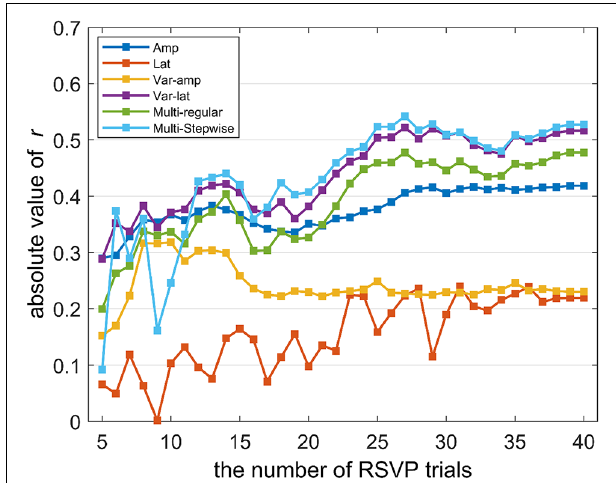
FIGURE 7 | The correlation changes over the number of trials. This represents the way correlations change when the number of RSVP trials used to calculate EEG features varies. The X-axis represents the number of trials (1st to Nth RSVP trial), and the Y-axis represents the Pearson’s correlation coefficient’s absolute